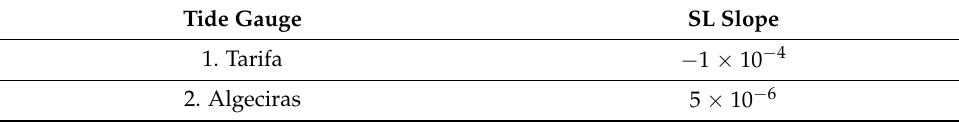
Figure 40. Evolution of SL maxima in Barcelona. Table 4. Summary of SL